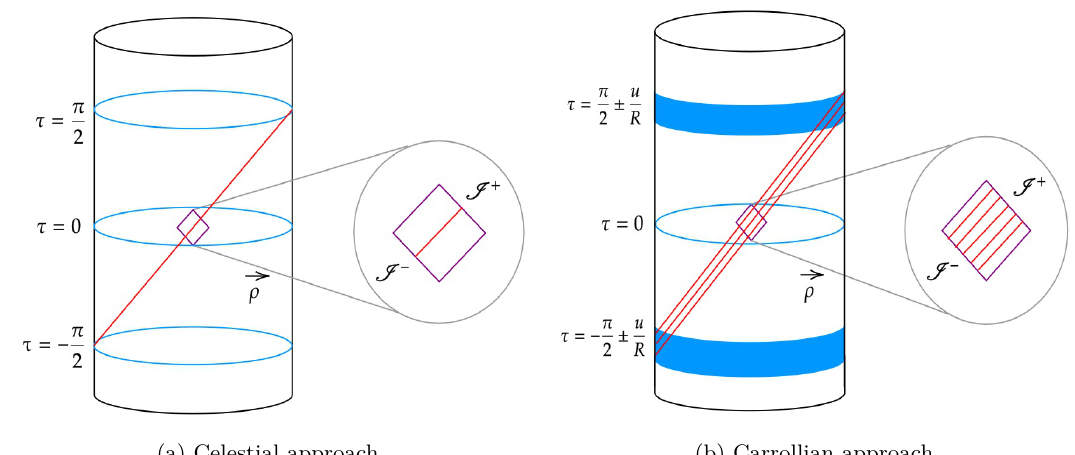
Figure 1. Different approaches to flat limit of